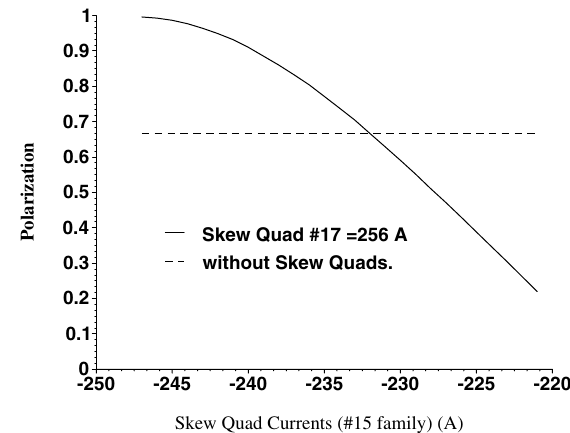
FIG. 7. Polarization after crossing the 0 (cid:5) (cid:28) resonance with u (cid:3) 8 : 8 , (cid:28) (cid:3) 8 : 7 ) versus currents fixed normal mode tunes ( (cid:28) v u for hypothetical skew quadrupoles in the 15th straight sections. The 17th skew quadrupole family was fixed at 256 A. The dashed line indicates base polarization without any skew quadrupoles skew quadrupoles in the 17th lattice position. For all four resonances a solution appears possible. However, over- coming the 36 (cid:5) (cid:28) resonance requires a current in excess u of 1200 A. Since this high current needs to be maintained only during the brief time of the resonance crossing it should be possible. Actually a lower skew quadrupole